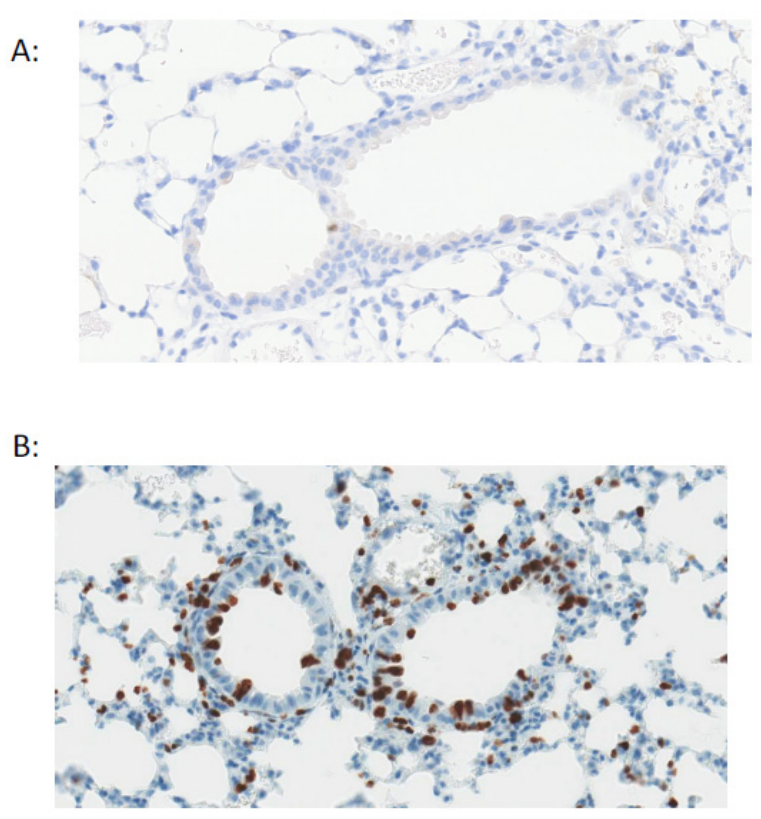
Figure 2. Pulmonary epithelial cells are quiescent during homeostasis. Staining for Ki67 +ve cells (brown) shows very low proliferation in the mouse airway under basal conditions ( A ) with an increase in proliferation after airway epithelial injury with naphthalene ( B ).